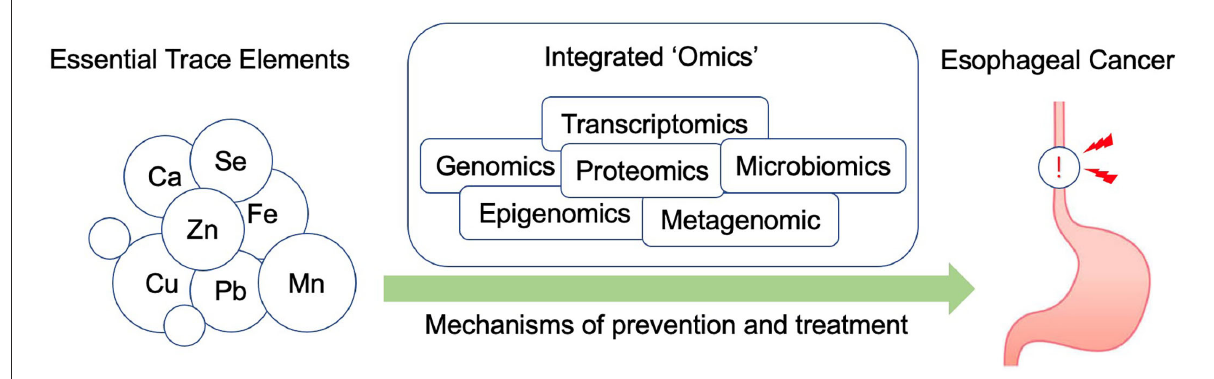
FIGURE1 An overview of how integrated omics technologies could be applied to study the relationship between essential trace elements and EC.